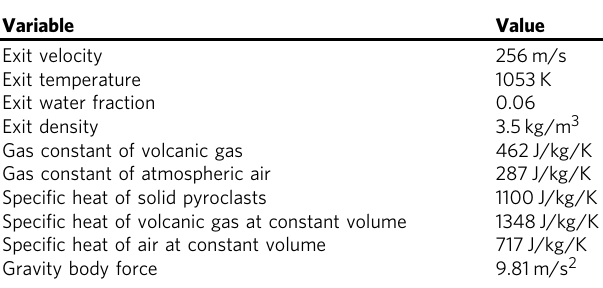
Table 1 Common input parameters and constants used